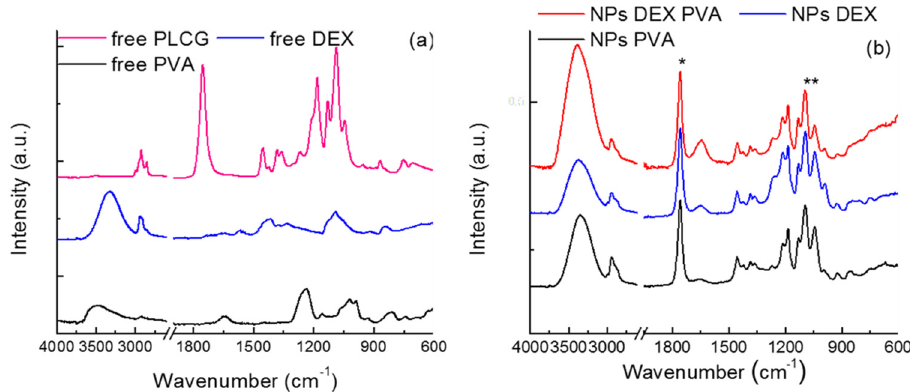
Figure 1. FTIR spectra of ( a ) free PLGC polymer and surfactants; ( b ) NPs prepared with the different surfactants. *: peak shifted towards higher frequencies; **: ratios between this peak and that at 1759 cm − 1 decreases.